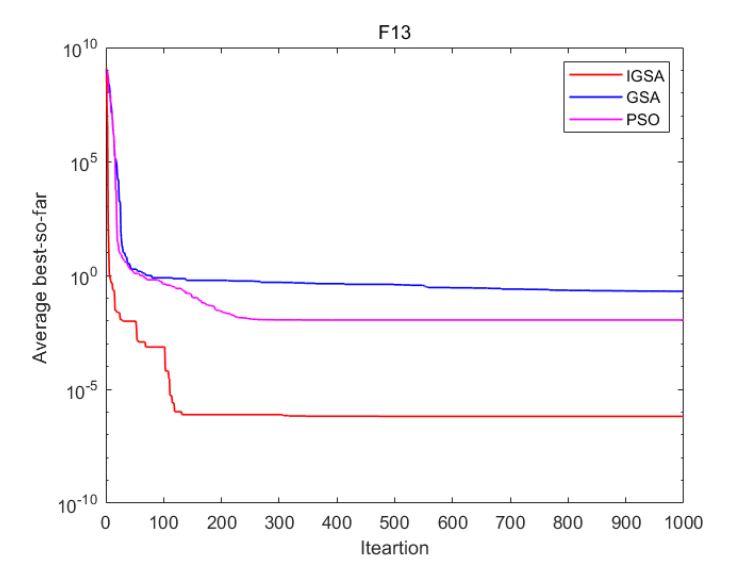
Figure 7. The convergence behavior of F 9 .